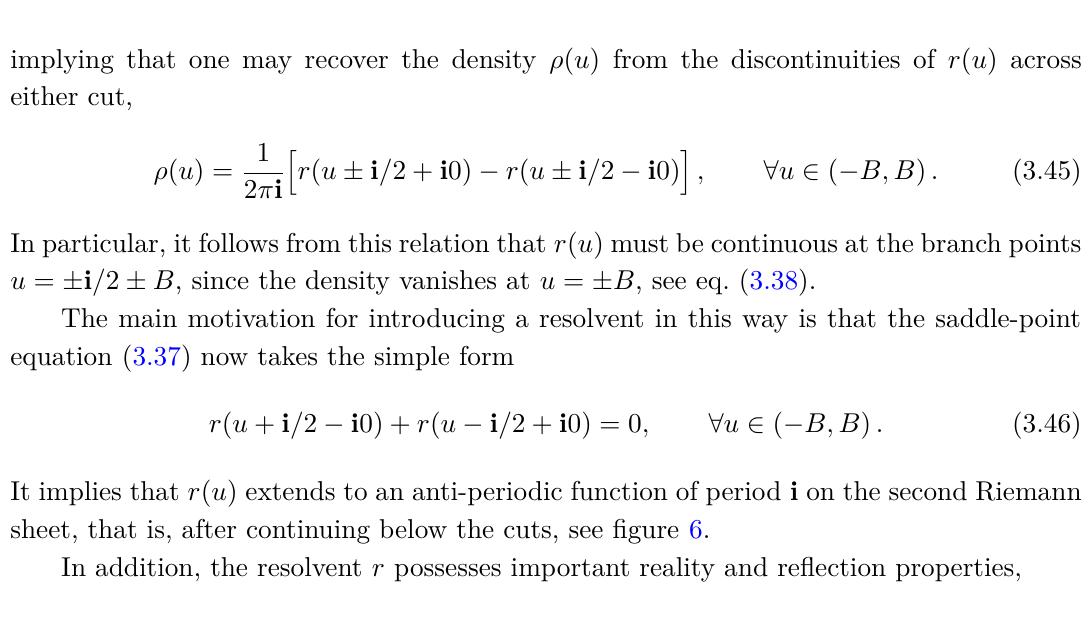
Figure 6 . Riemann sheet structure of the resolvent r ( u ) . There is a simple pole at the origin (and at infinity) and two cuts of length 2 B spaced by i . The periodicity condition identifies the values of the functions above and below the cuts, up to a